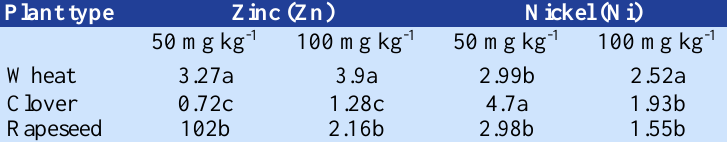
Table 3 . Mean comparison of bioaccumulation factor for zinc (Zn) and nickel (Ni) collecting from the soil by wheat, clover and